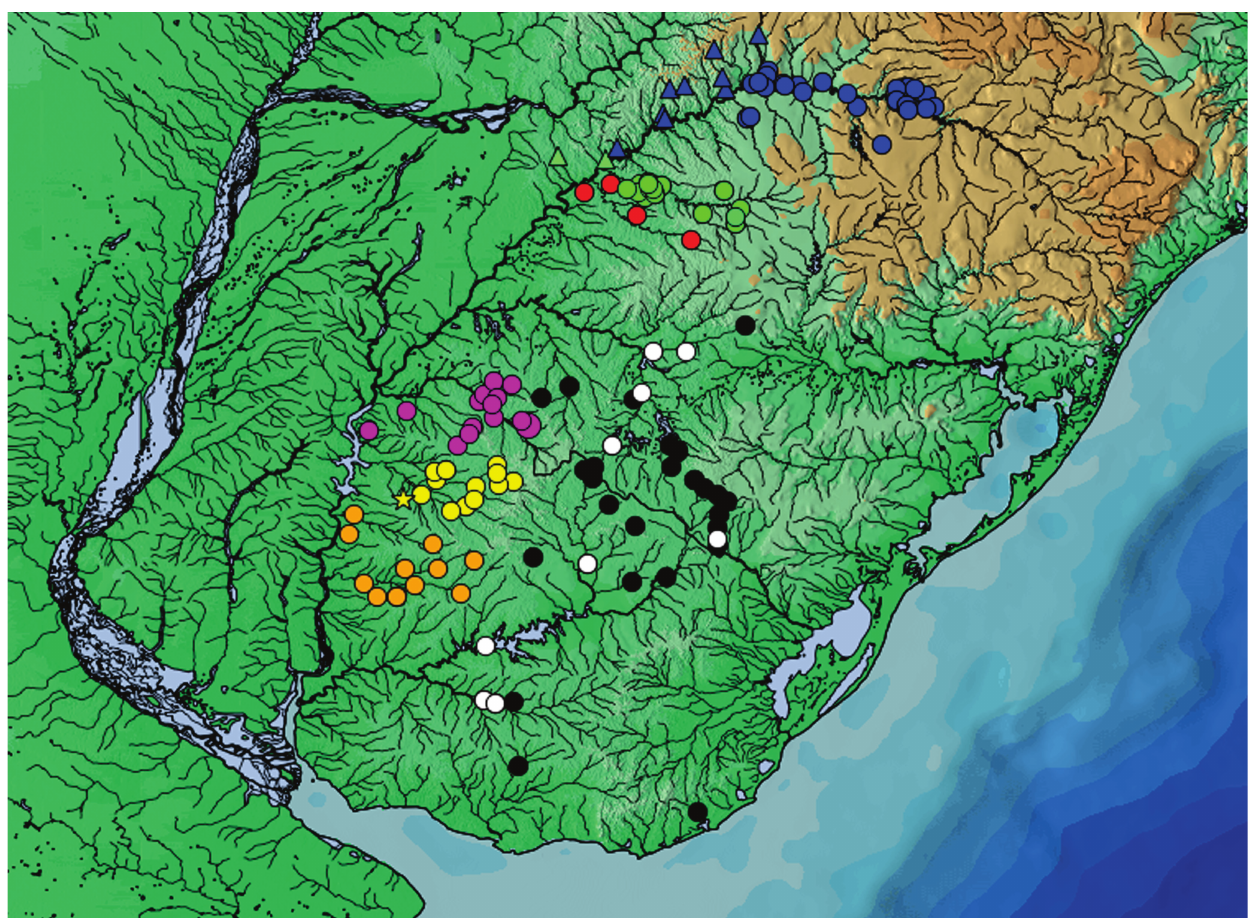
Fig. 6 . Geographic distribution of Gymnogeophagus peliochelynion (yellow; star refers to type-locality), G . cf. peliochely- nion (orange) and other species of the Gymnogeophagus gymnogenys clade: G. lipokarenos (blue), G. constellatus (green), G. missioneiro (red), G. tiraparae (white), G. mekinos (black), G. pseudolabiatus (pink) in the río Uruguay basin. Records of Gymnogeophagus lipokarenos and Gymnogeophagus constellatus from Argentina (triangles) are based on Casciotta et al . (2017b) and Říčan et al . (2017),